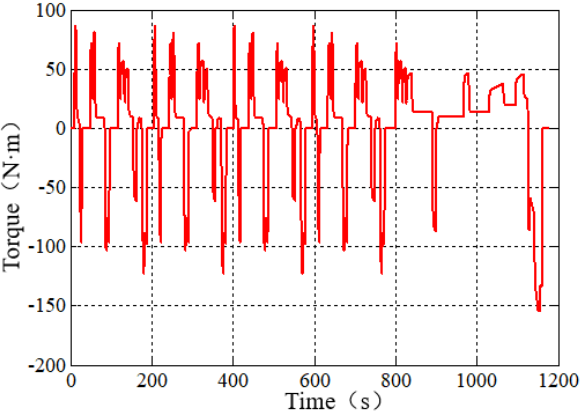
Figure 13. Motor torque in the NEDC condition.